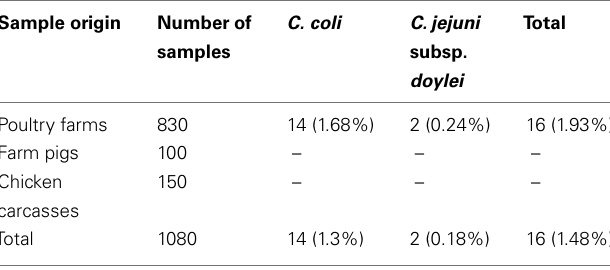
Table 2 | 16S rRNA gene sequencing identification of Campylobacter spp. isolated from poultry and other animal